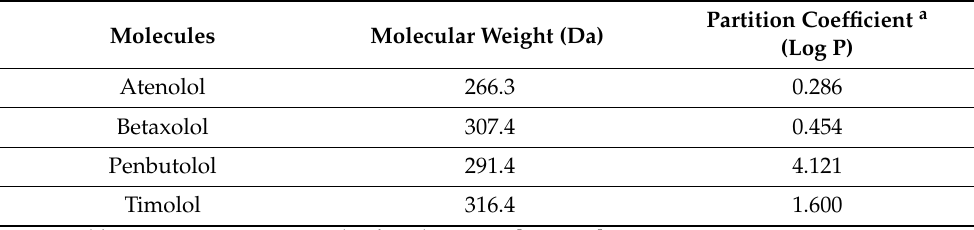
Table 8. Physicochemical properties of the beta-blocking drugs under